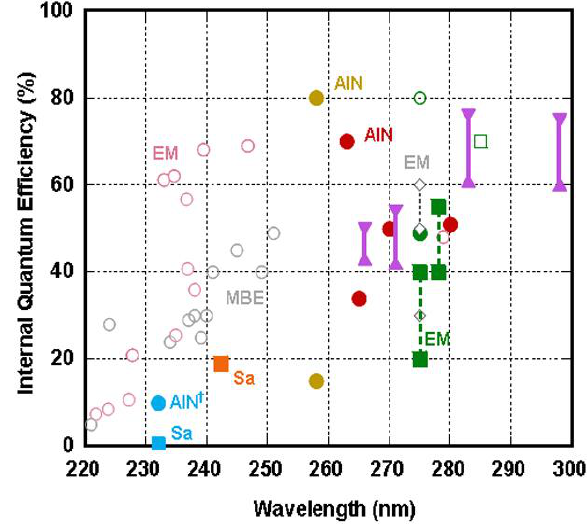
Figure 17. The reported IQE dependence on the wavelength is collected and mapped. This graph includes the calculations and IQEs under unclear excitation conditions, as shown by hollow symbols. The solid symbols ● [61], ● [137], ● [24], ■ [25], ■ [90], and ●■ [136] denote the nonsaturated excitations for flat MQWs. Our estimated ranges for the uneven QWs are shown by ( ▲ and ▼ ). AlN † indicates the uneven MQW grown on bulk AlN with a miscut of 3.0° shown by ● , and ■ refers to the flat MQW grown on sapphire [136]. EM denotes the enhanced migration method used for AlN growth on sapphires. MBE indicates samples prepared by a molecular beam epitaxy method.